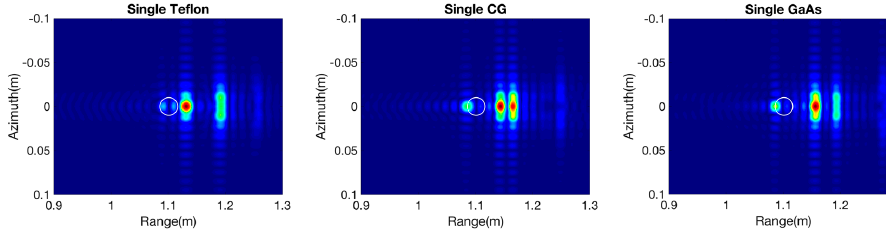
Figure 5. Images of dielectric spheres ( left : Teflon; center : glazed ceramic; right : GaAs).